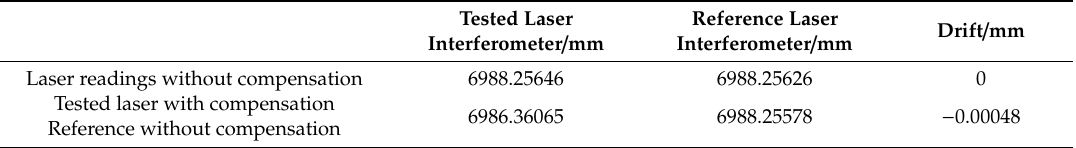
Table 5. Example of software check of environmental conditions using displacement